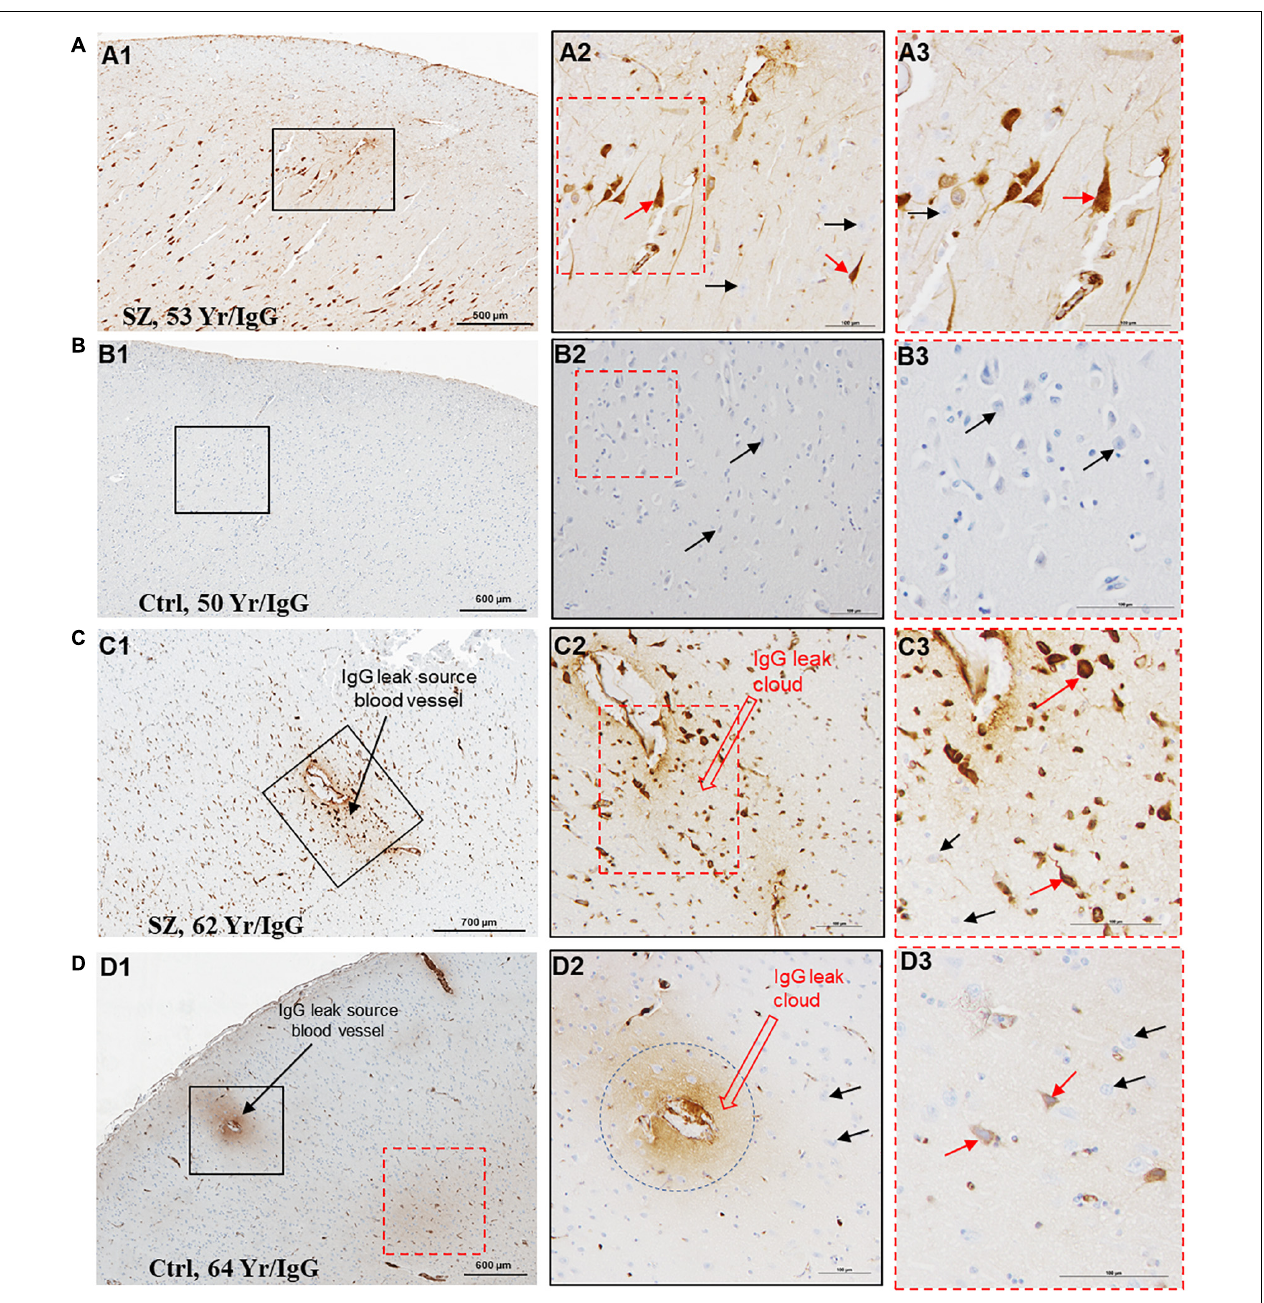
FIGURE 2 | Temporal cortex near hippocampus of SZ patients demonstrates increased BBB permeability and selective interaction between IgGs and pyramidal neurons. (A–D) Representative immunohistochemistry images showing the detection of extravasated IgGs (brown color) in parenchyma temporal cortex surrounding hippocampus proper from SZ and Ctrl subjects. These sections were probed with biotinylated anti-human IgG antibodies. As revealed by the brown staining, once in the brain parenchyma, IgGs selectively interact with neuropil and a subset of neurons (red arrows). The temporal cortex demonstrated a greater incidence of IgGs immunoreactivity in SZ patients compared to Ctrls of similar age. The neurons without IgG immunoreactivity are denoted by black arrows. Scale bar (in µ m): A = 500 and 100; B = 600 and 100; C = 700 and 100; and D = 600 and